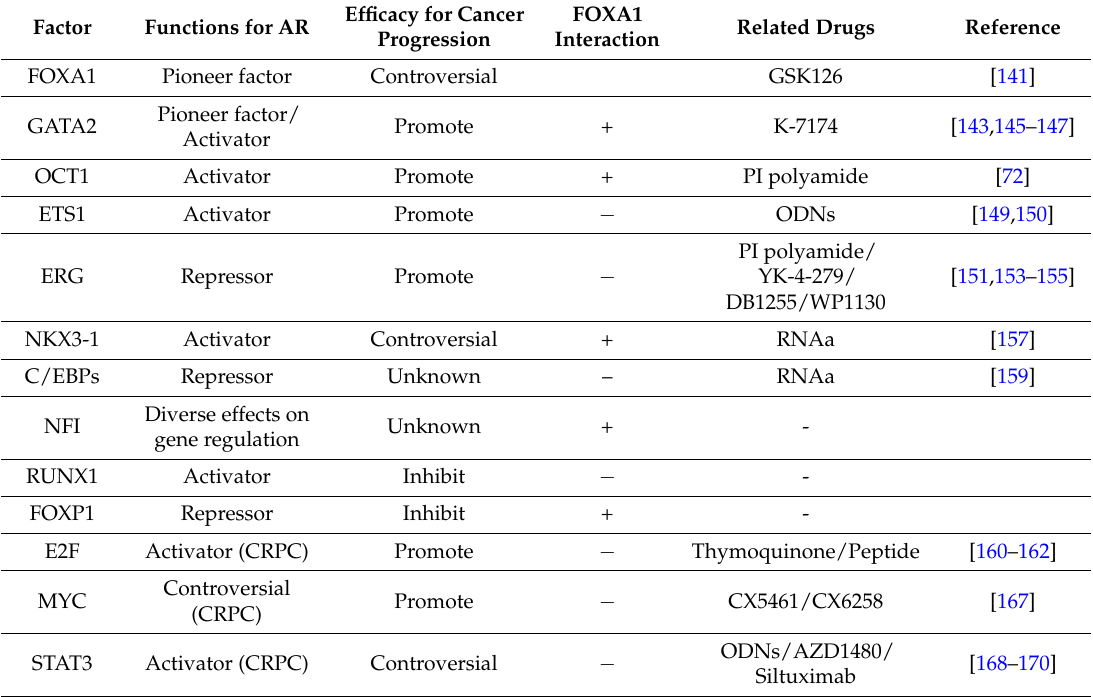
Table 1. AR collaborative